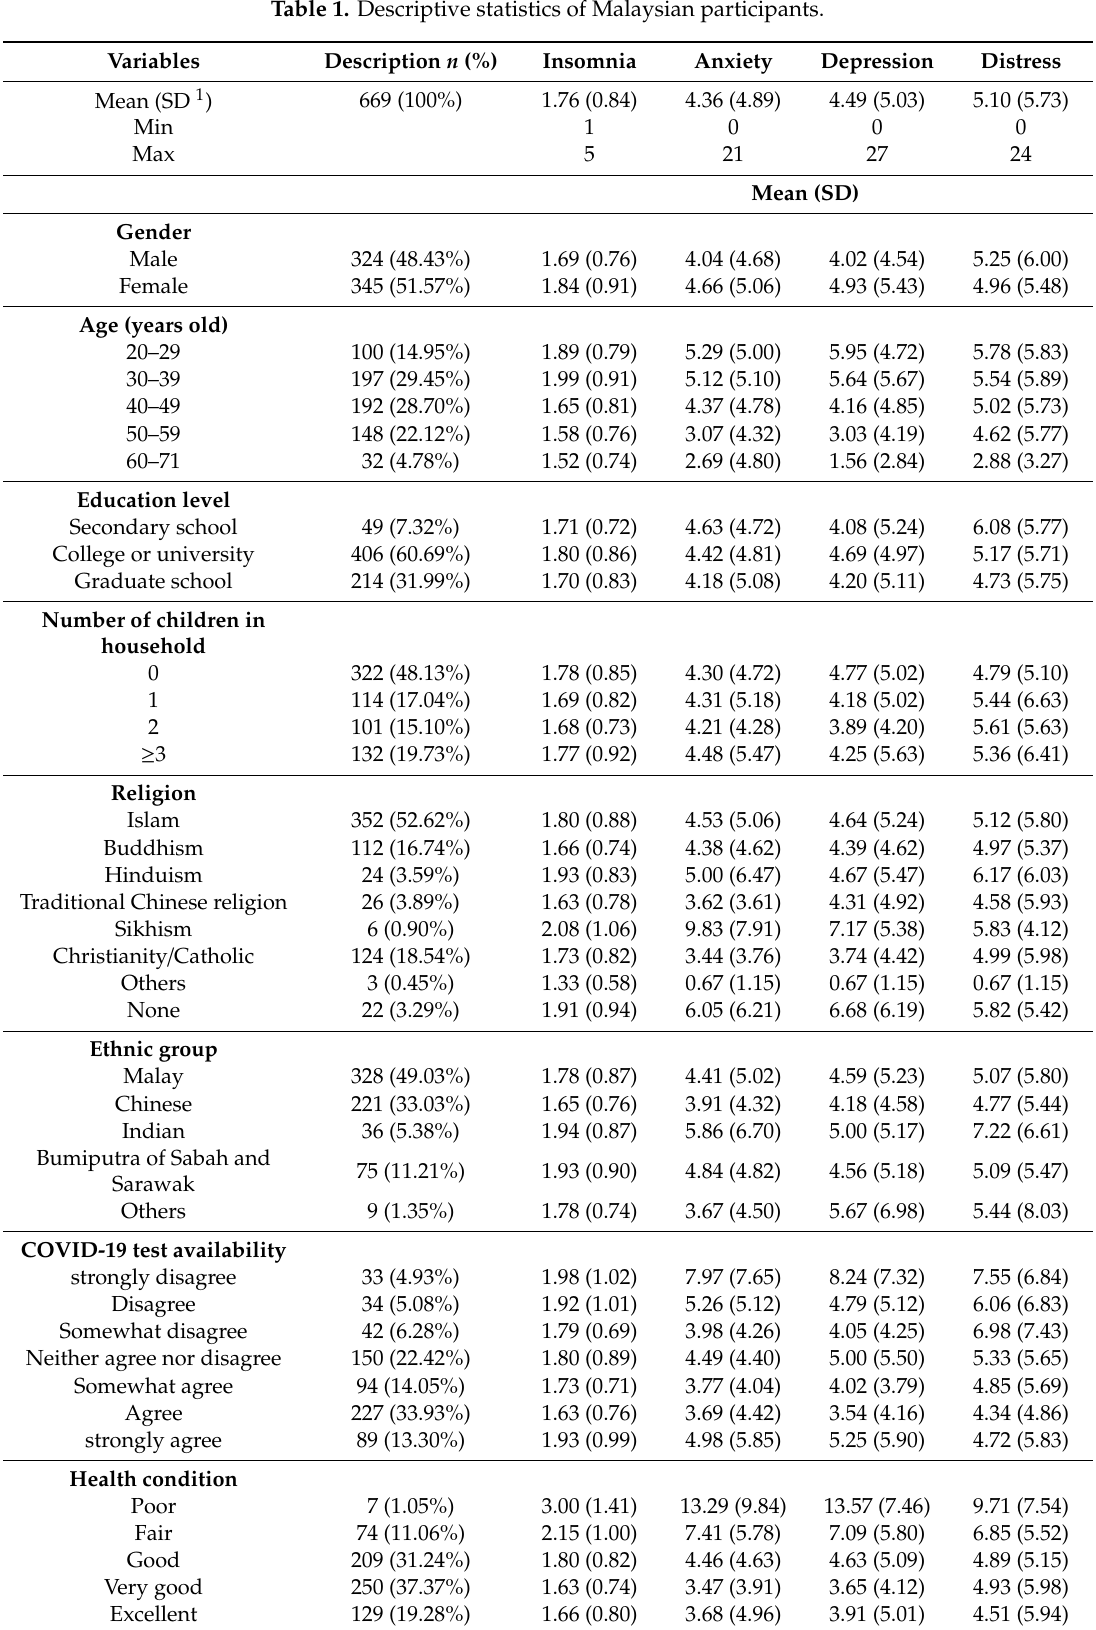
Table 1. Descriptive statistics of Malaysian